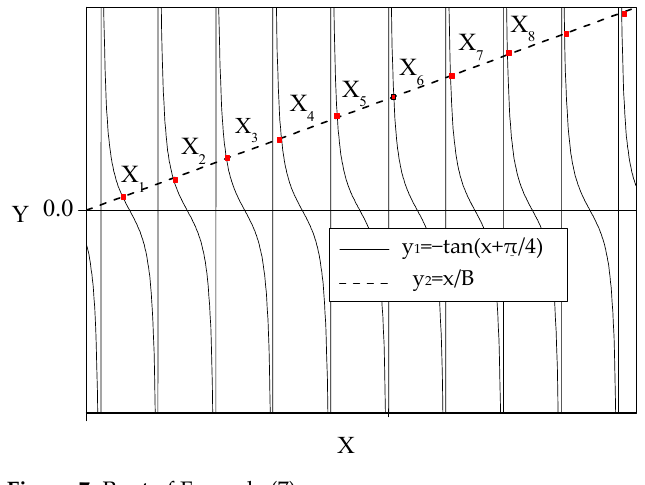
Figure 7. Root of Formula (7).